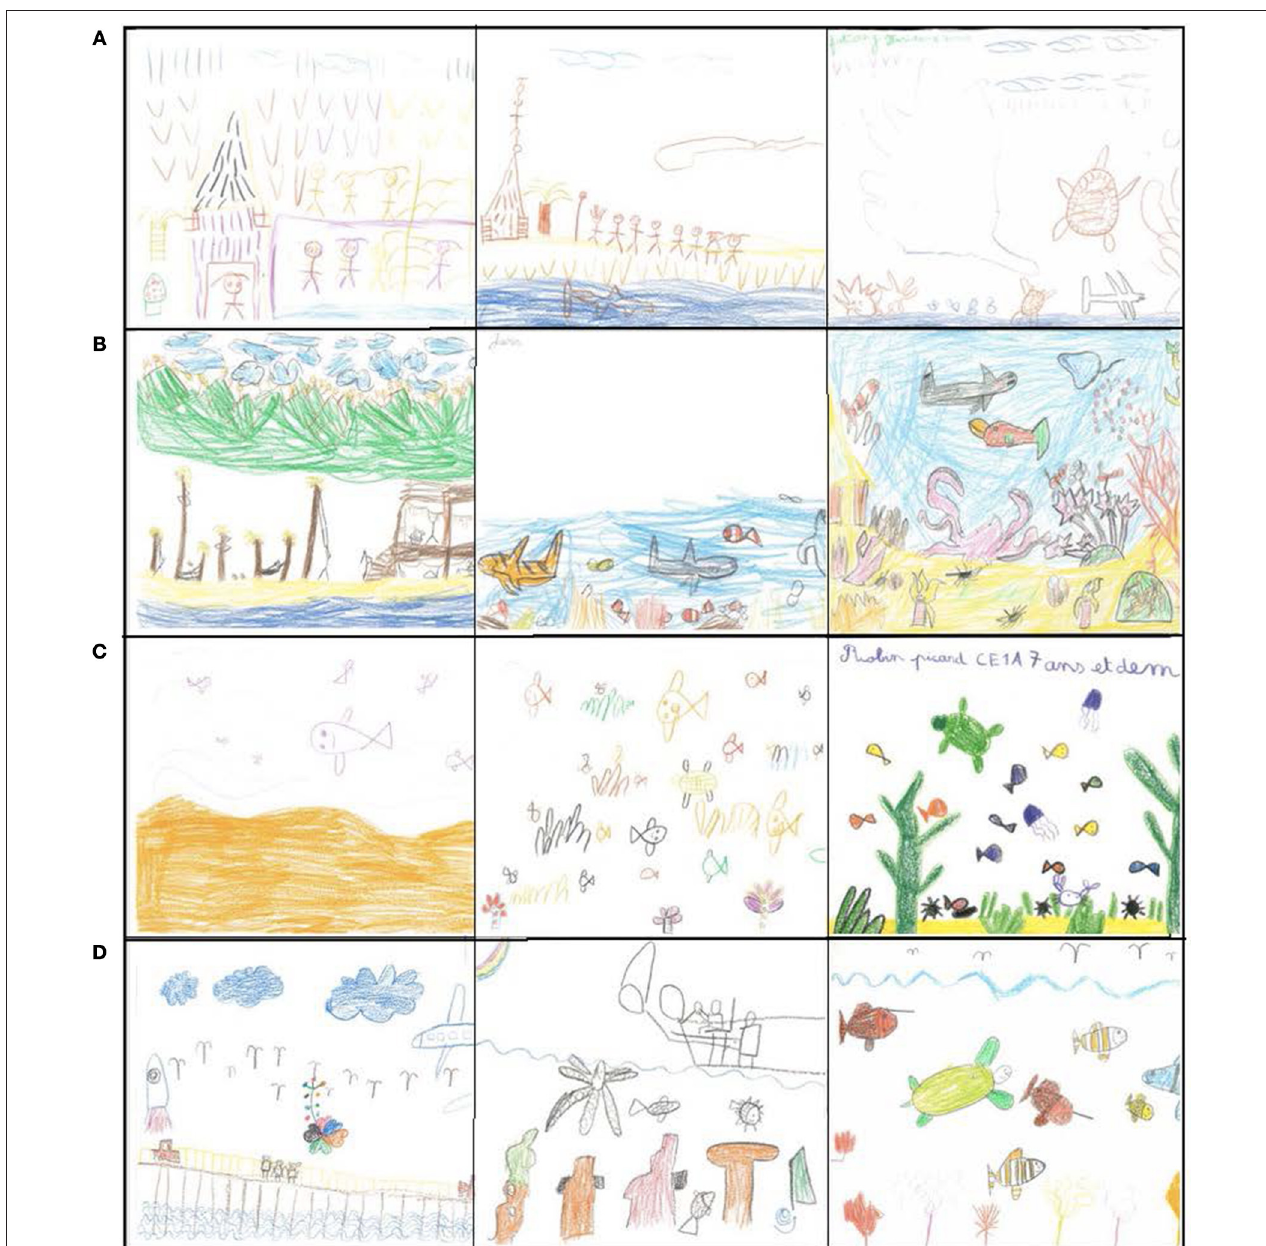
FIGURE 9 | Sequences of 4 Sea-Reef1-Reef2 drawings for 4 children (first name) who drew interesting features to highlight and scool indicated in parentheses. From up to below (A) Folialki (Noell), (B) Jaurès (Noell), (C) Robin (Boyer), (D) Yansi (Banian). Boyer: socially advantaged urban neighborhood, Noell: less advantaged urban neighborhood, Thio: coastal area close to a marine reserve, Banians: coastal area within a large fishing community, Coula: rural environment.